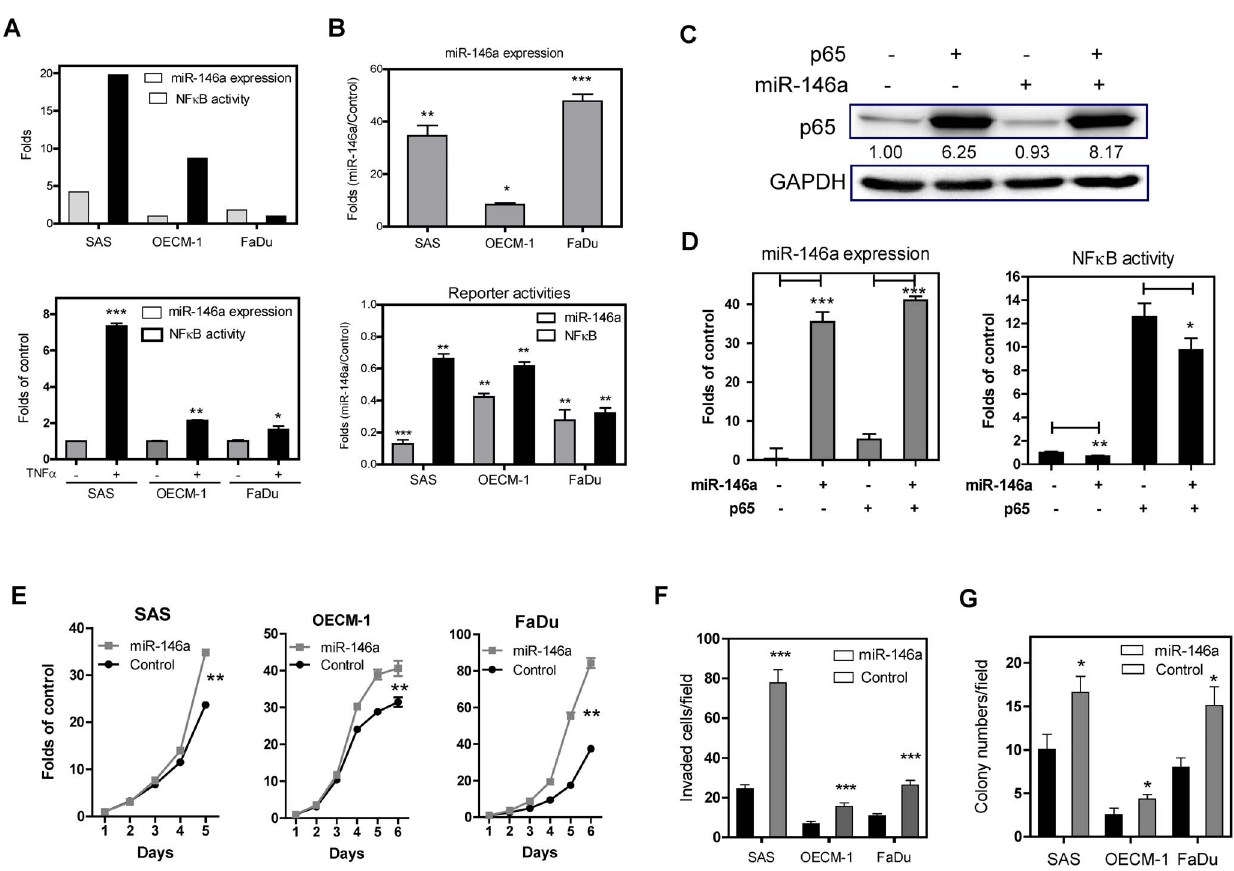
Figure 2. Exogenous miR-146a expression enhances OSCC oncogenicity. (A) Upper, The OSCC cells have various endogenous levels of miR- 146a expression (the level of OECM-1 cells serves as baseline) and of NF k B activity (the level of FaDu cells serves as baseline). Lower, TNF a treatment up-regulates miR-146a expression in OSCC cells. (B) The OSCC cell subclones show an increase in miR-146a expression (Upper), an increase in miR- 146a activity and a decrease in NF k B activity (Lower). (C, D) Exogenous p65 expression in SAS cell subclones. (C) Western blot analysis showing exogenous p65 expression after transfection. (D) miR-146a expression (Lt) and NF k B activity (Rt). The analysis shows that miR-146a expression only slightly down-regulates endogenous or exogenous NF k B activity. The fold changes in (D) are determined by normalization against the control cells transfected with empty vector. (E - G) Proliferation assay, invasion assay and AIG analysis performed on the OSCC cell subclones. Exogenous miR-146a expression in OSCC cells increases these oncogenic phenotypes to different extents. The folds in (E) are defined by normalization against the cell numbers at different time points relative to the numbers of cell seeded. Data are shown as mean 6 SE from at least triplicate analyses. (C) is a representative picture of three individual experiments and the numbers are the normalized values. *, p , 0.05; **, p , 0.01; ***, p , 0.001; Mann- Whitney test or Two-Way ANOVA test.